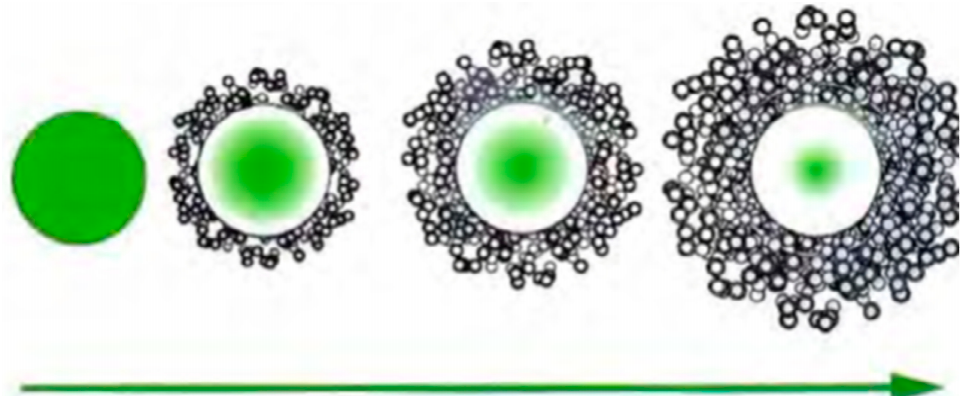
Figure 6. Schematic representation of the diffusion of an active system with the polymeric membrane, adapted from Bezerra [108].